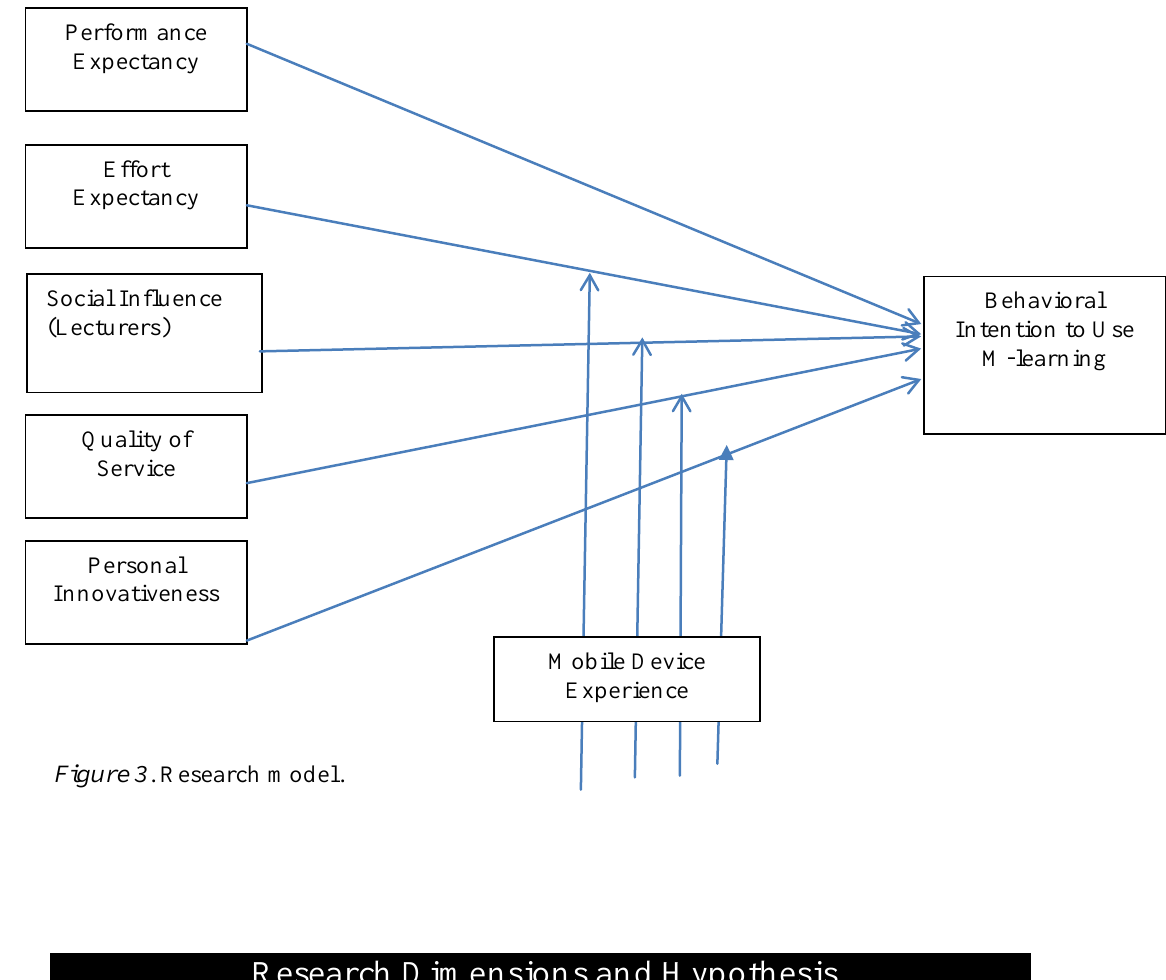
Figure 3 . Research